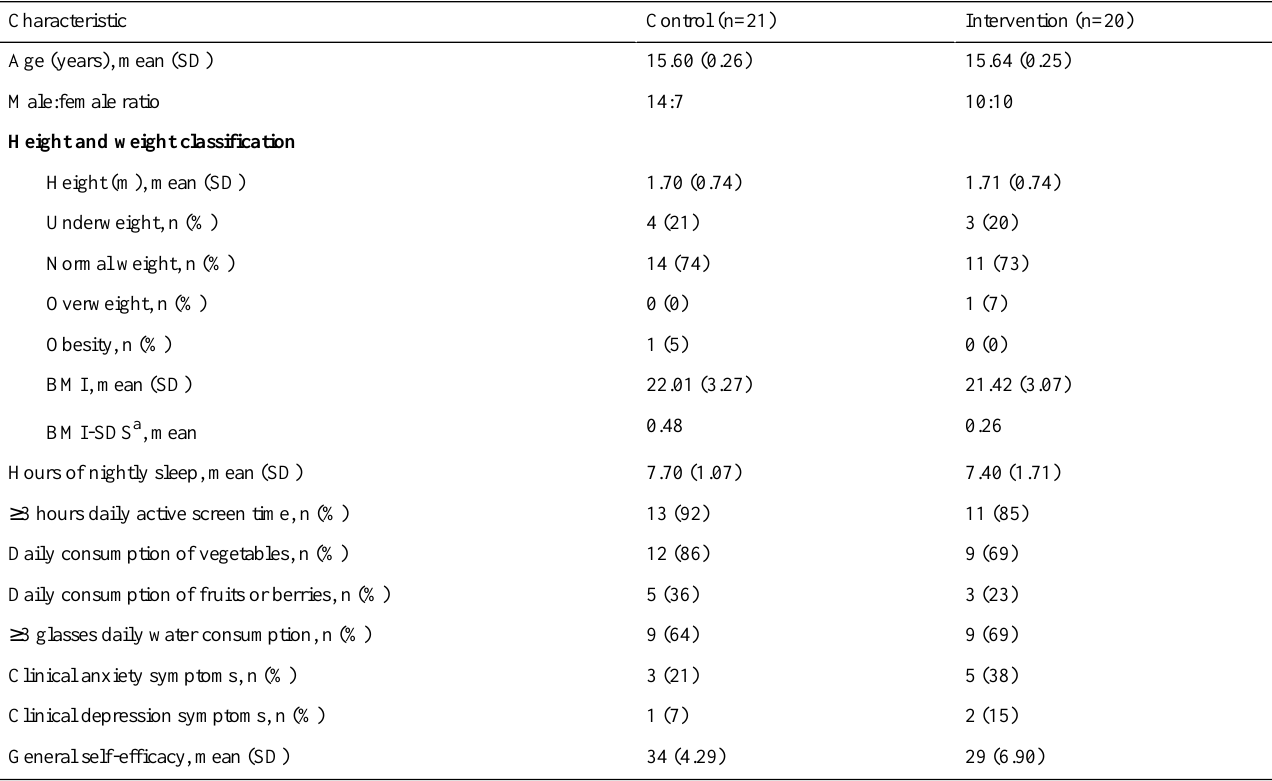
Table 1. Baseline characteristics of